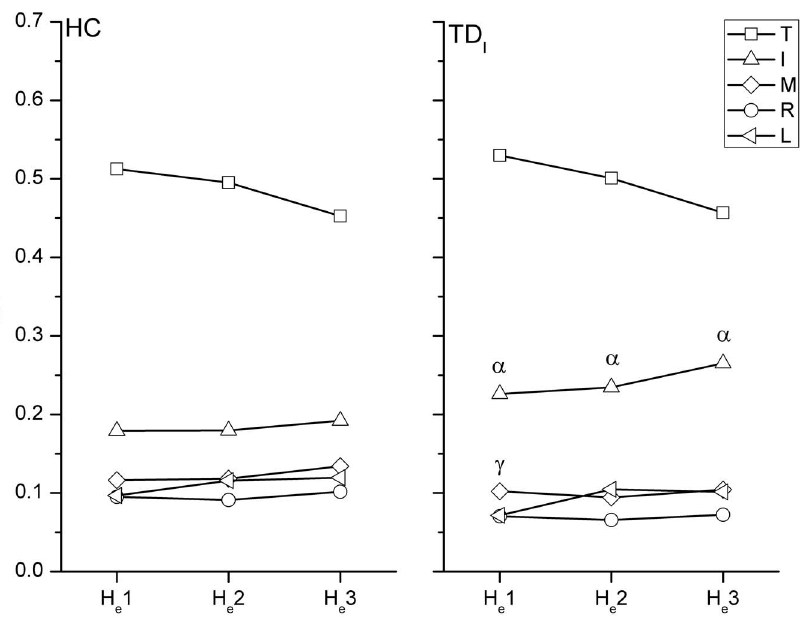
Figure 5. The significant difference of CR between TD I and HC during holding. The force contribution ratios of each digit during the holding task in HC and TD I . A higher CR of the index finger and lower CR of the ring and middle fingers were noticed in TD I . Significant differences (p , 0.05) in CR with regard to specific digits between HC and TD groups are indicated by the following symbols: a means the index finger and c means the ring finger.